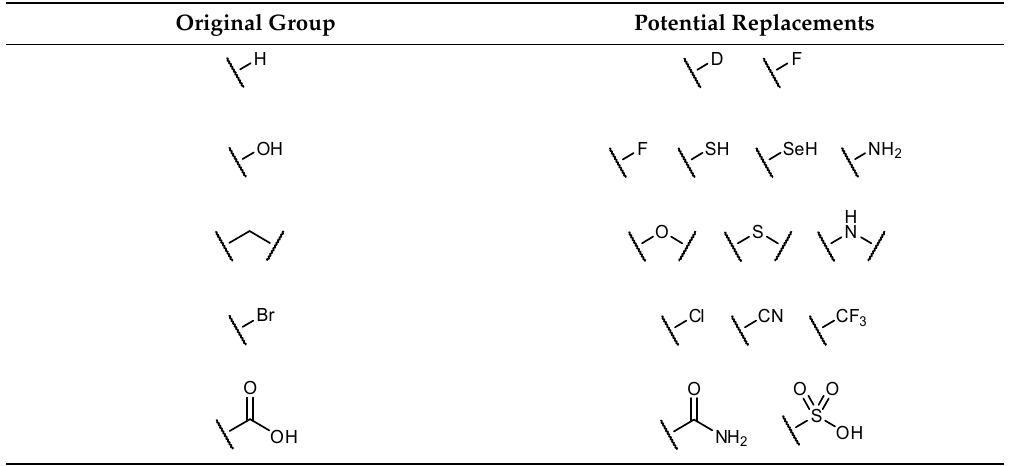
Table 1. Examples of bioisosteric groups.